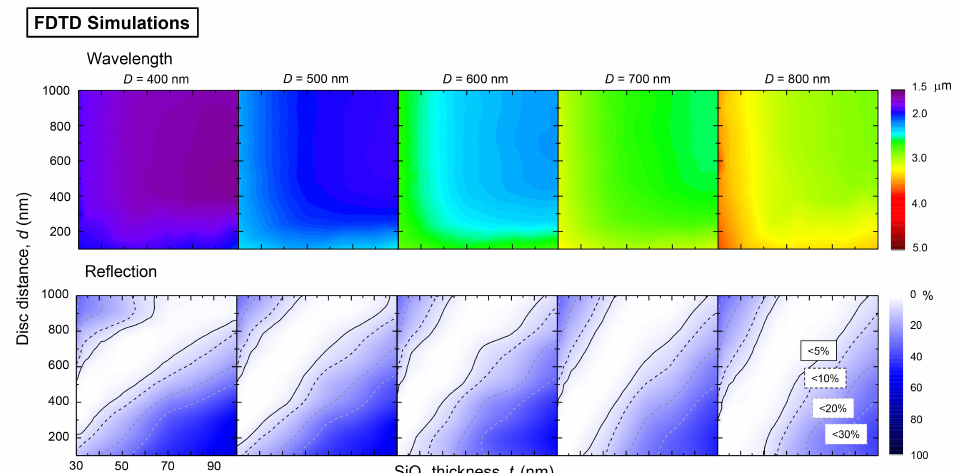
Figure 3. FDTD simulation results of resonance wavelength (color-coded) and minimum reflectance that were obtained from the series of reflection spectral measurements with parameters of disc diameter D , disc distance d , SiO 2 thickness t i . See Figure 2 for comparison with experimental